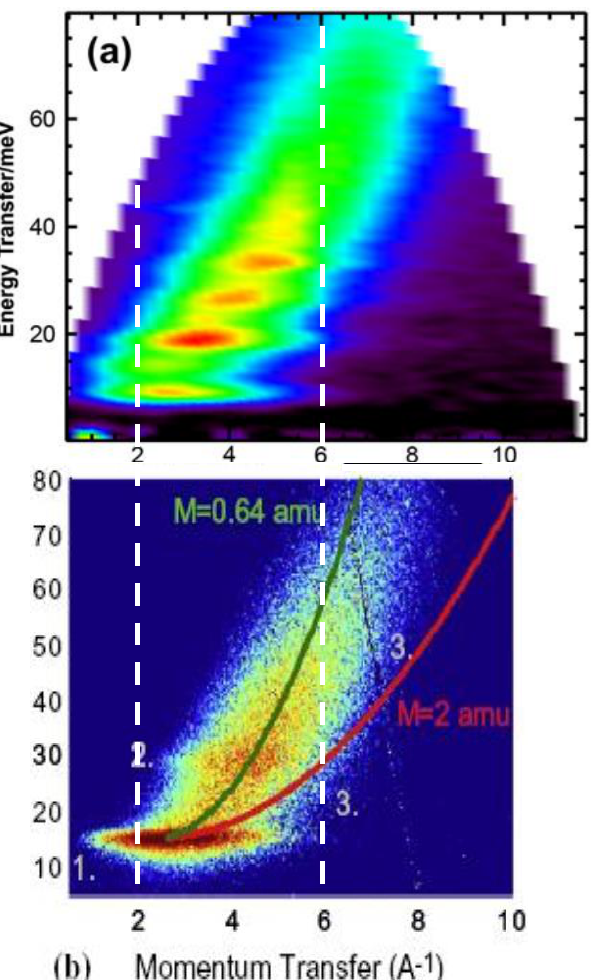
Figure 5. Comparison of the two experimental results: Experimental S ( K , E ) maps of the two original papers, appropriately stretched/scaled to facilitate comparison. ( a ): data from [29]; ( b ) data from [28]. The shown two vertical dashed lines (white) are guides to the eye. The two broad continuous ribbons due to the translational modes are virtually identically positioned in the momentum-energy plane K − E